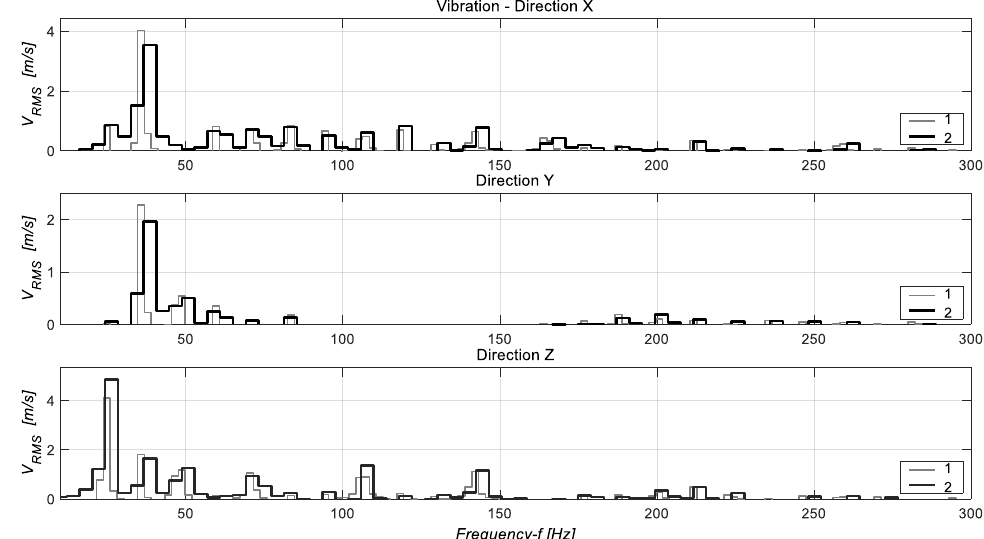
Figure 9. The fault at point 4 where the foundation frame is mounted to the ground — spectrum of the effective vibration velocity value: 1 — rated signal; 2 — signal during the breakdown. the effective vibration velocity value: 1—rated signal; 2—signal during the